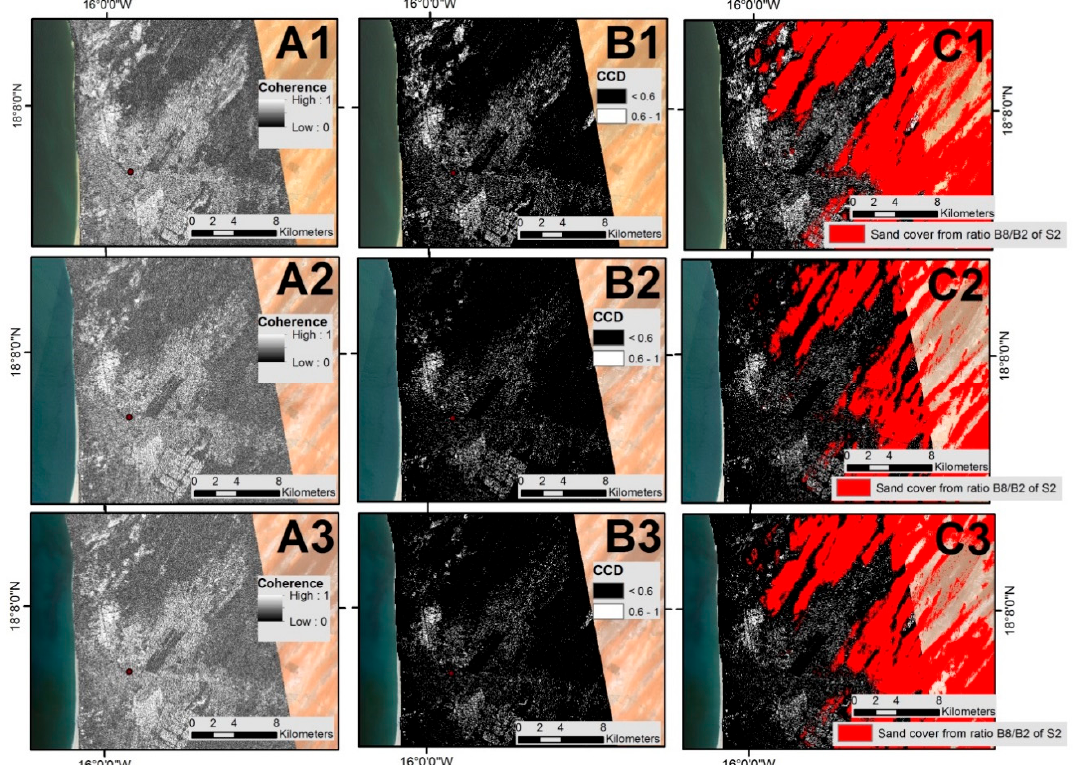
Figure 10. ( A ) Coherence images corresponding to the following image pairs: master (7 February 2017) and, respectively, slaves: 20 April 2017 (1), 13 July 2017 (2) and 17 October 2017 (3). ( B ) Coherence Change Detection (CCD) images with the 0.6 threshold and then the output of the B8/B2 ratio from Sentinel 2 images overlaid ( C ).